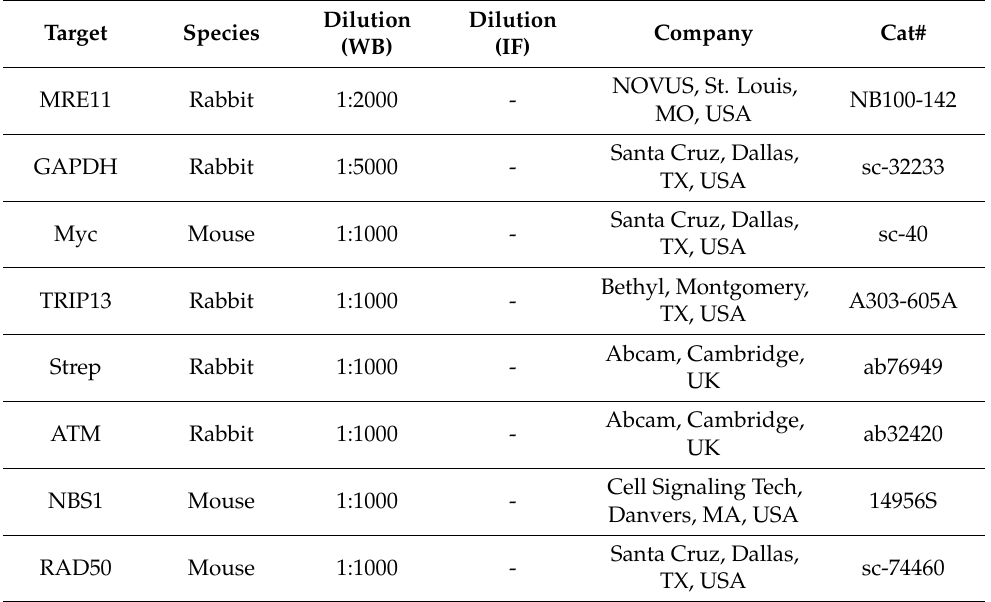
Table 1. A list of the antibodies used in this study. IF, immunofluorescence; WB, Western